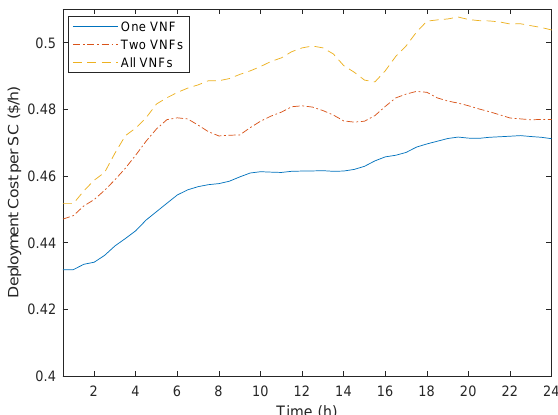
Figure 6. Impact of the Neighborhood of Local Search in Tabu Search.